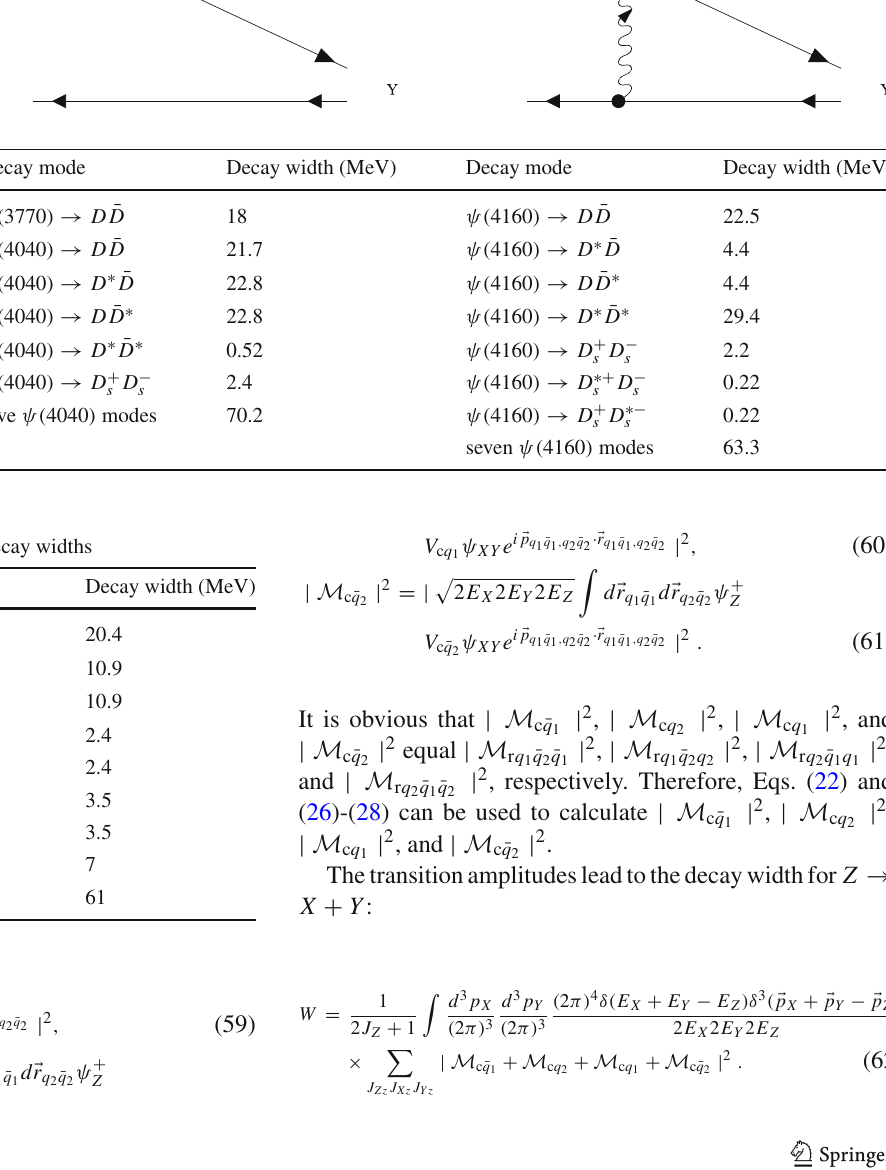
decay widths of ψ( 3770 ) , ψ( 4040 ) , and ψ( 4160